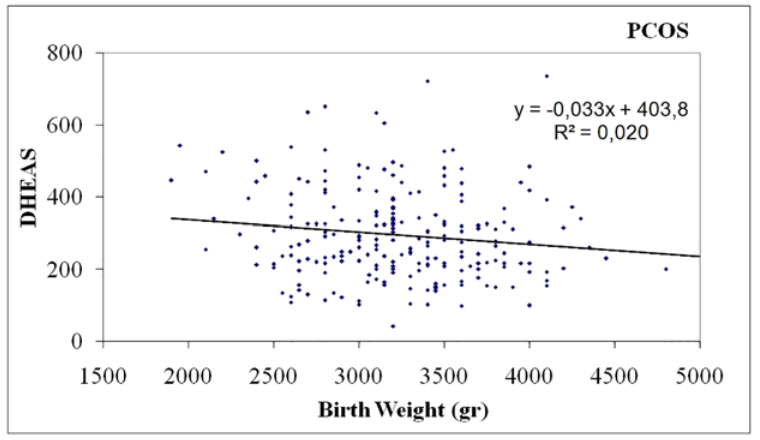
Fig 1. Negative correlation of birth weight with DHEAS levels in women with PCOS.